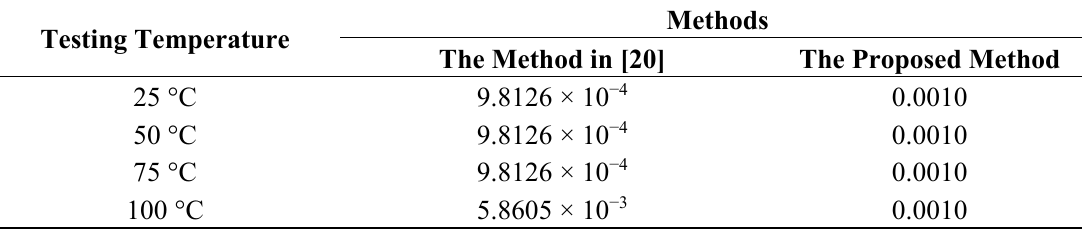
Table 7. Results obtained by different methods for the single diode model in nonstandard test